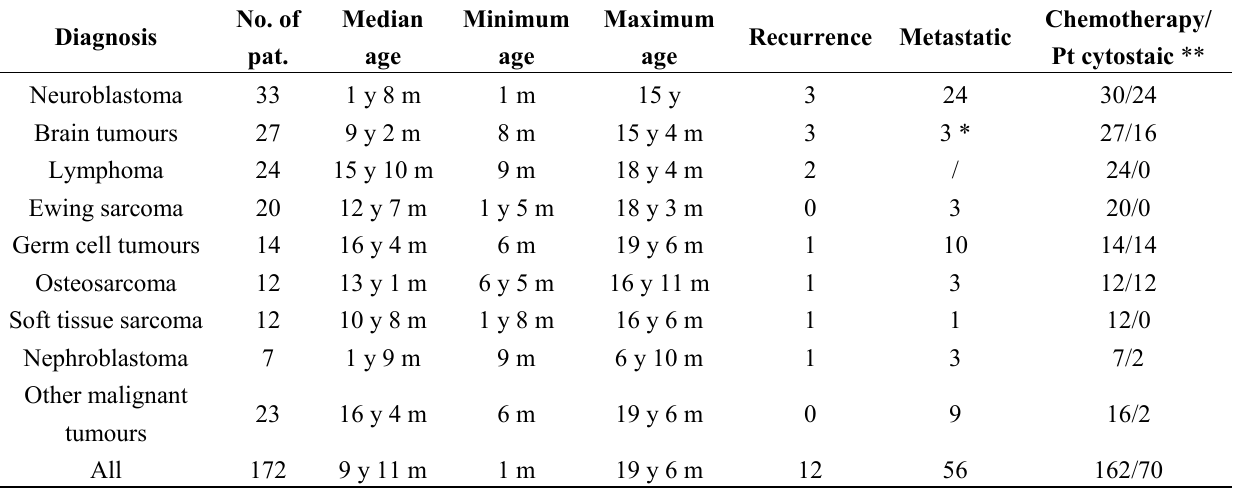
Table 2. Clinical characteristics of patients